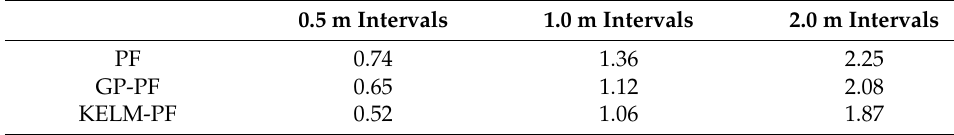
Table 1. Positioning accuracies of the same test nodes under different